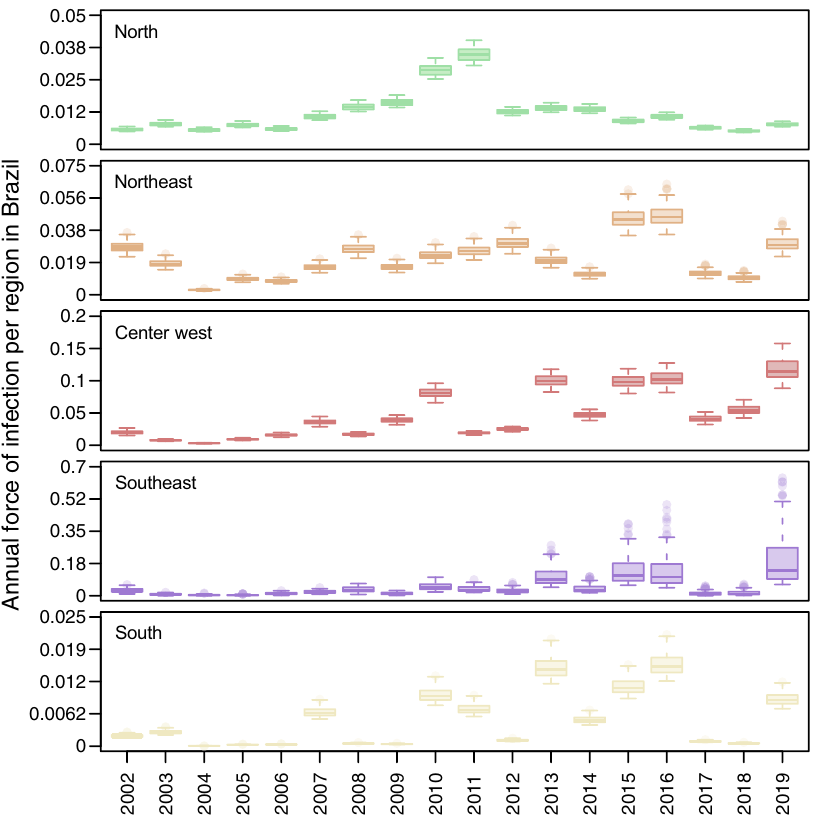
Fig. 3 Dengue virus force of infection was low in 2017 and 2018 but consistent with other years in the recent past. Values displayed here come from the set of 100 fi nal estimates, which re fl ect the top 10% of 1000 parameter sets. These originally involved sampling ~ γ F and ~ γ S from assumed uniform priors (speci fi ed in Table S1) and then fi nding maximum-likelihood estimates of other model parameters. Boxes indicate the interquartile ranges and whiskers indicate the 95% quantiles of those 100 points, with dark lines representing median estimates. The regions and colors correspond to the map in Fig. 1B.